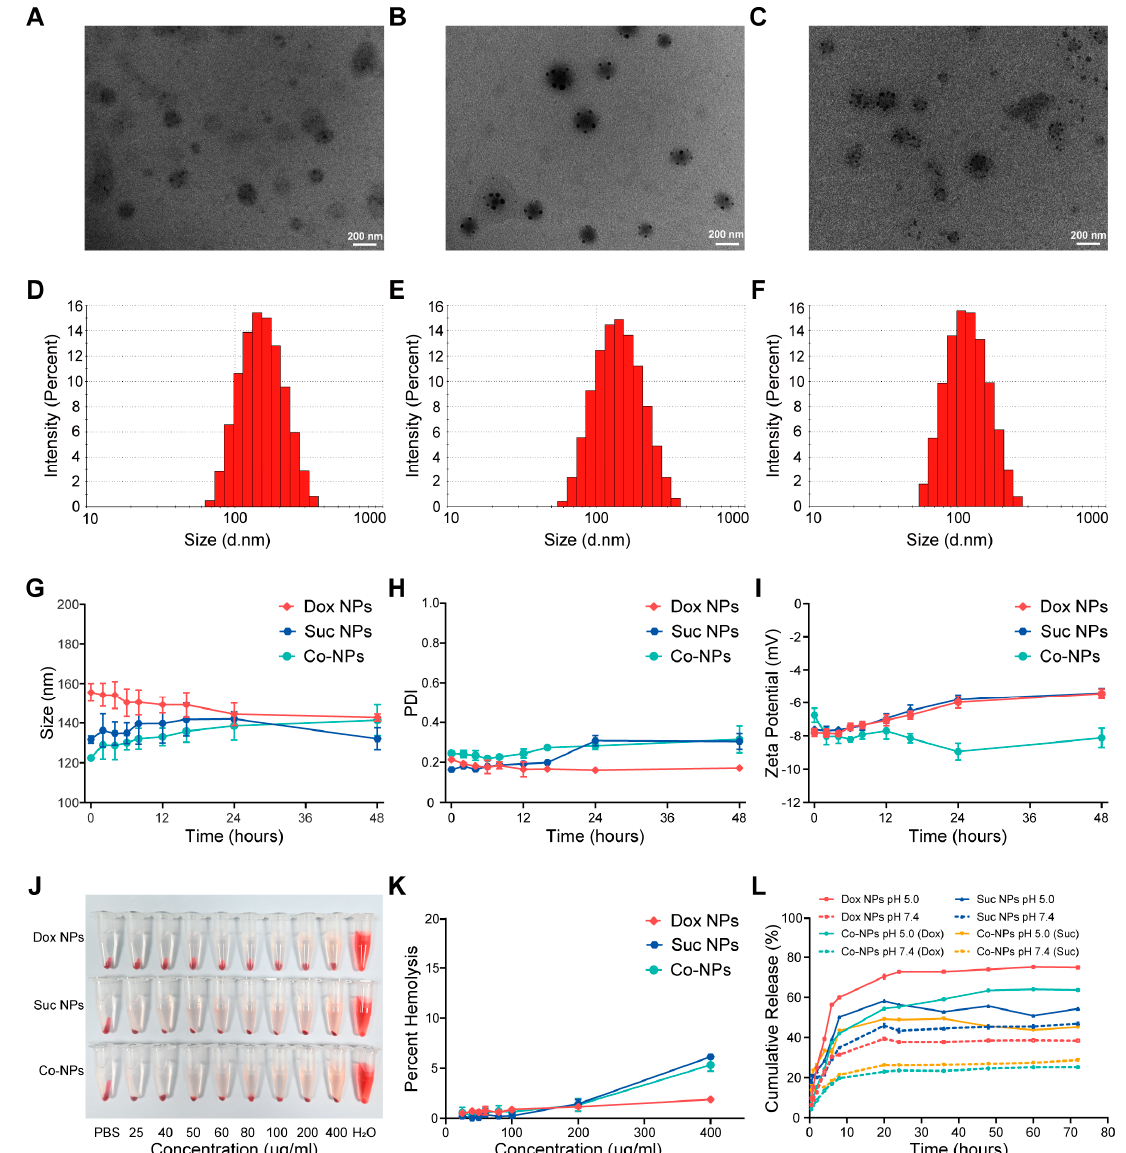
Figure 1. Characterization of different nanoparticles. ( A – C ) TEM images of Dox NPs ( A ), Suc NPs ( B ), and Co-NPs ( C ). ( D – F ) Particle size distribution of Dox NPs ( D ), Suc NPs ( E ), and Co-NPs ( F ). ( G – I ) Size ( G ), PDI ( H ), and zeta potential ( I ) of Dox NPs, Suc NPs, and Co-NPs in PBS (pH 7.4) within 48 h ( n = 3). ( J ) Hemolysis assay of Dox NPs, Suc NPs, and Co-NPs at different concentrations